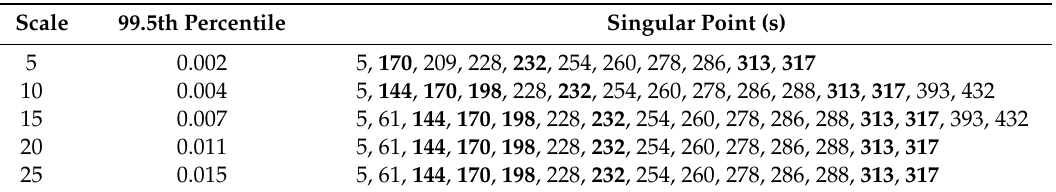
Table 2. 99.5th percentile of the CWT coe ffi cient and singular points (s).